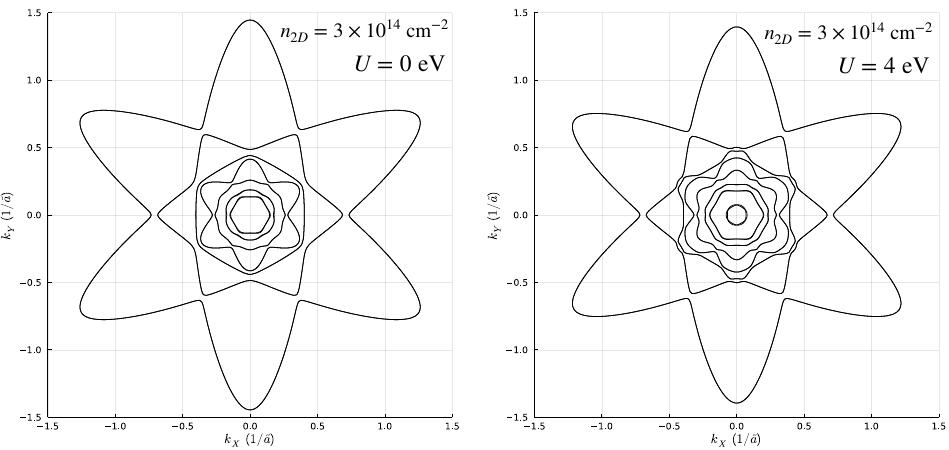
Figure 4. Fermi surfaces for the benchmark choice of n 2 D = 3 × 10 14 cm − 2 in the absence ( left panel ) or presence ( right panel ) of